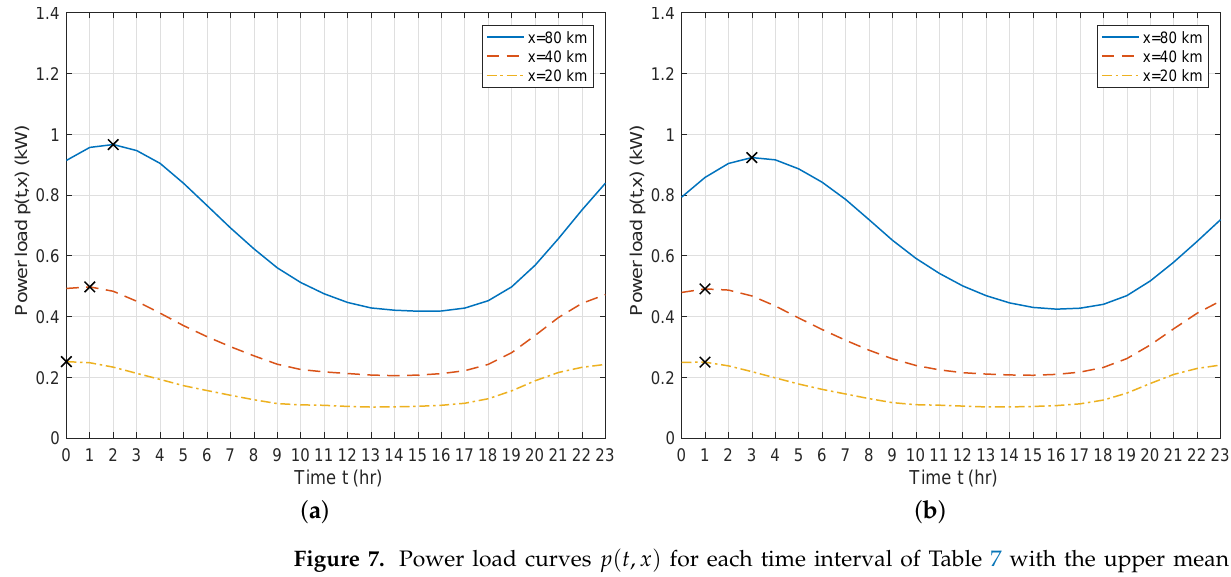
Figure 7. Power load curves p ( t , x ) for each time interval of Table 7 with the upper mean fuel efficiency of α = 5.44 km/kWh. The charging start time distribution of Figure 5 is used, and the charging efficiency is η = 0.95. ( a ) The charging power is ¯ ρ = 3 kW. The maximum power of x = 80 km is 0.966 kW at 2:00 a.m. ( b ) The charging power is ¯ ρ = 2 kW. The maximum power of x = 80 km is 0.923 kW at 3:00 a.m.